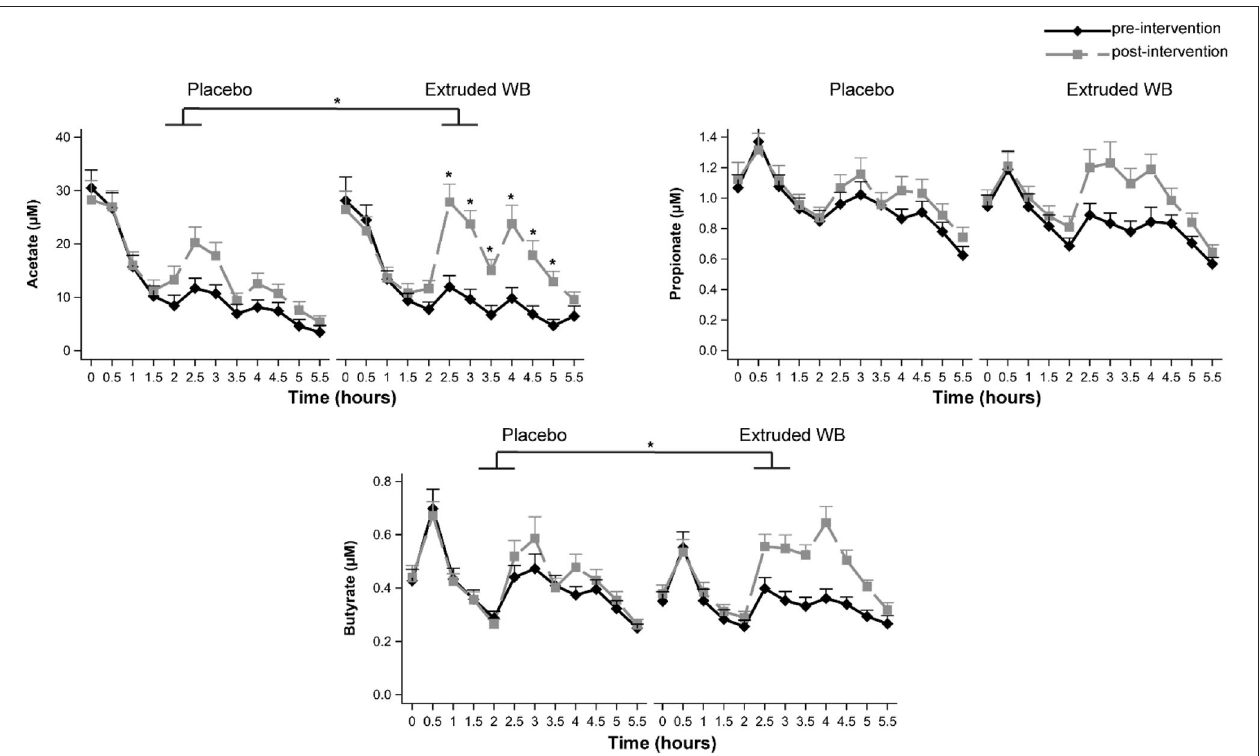
FIGURE 2 | Serum short-chain fatty acid (SCFA) concentrations at pre- and post-intervention visits. Blood samples were collected throughout both study visits at 30-min intervals. Consumption of extruded wheat bran (WB) resulted in significant increases in acetate and butyrate (all p < 0.05), which were most pronounced from 2.5 to 5h. Graphs show mean SCFA concentrations ± SE . * p <